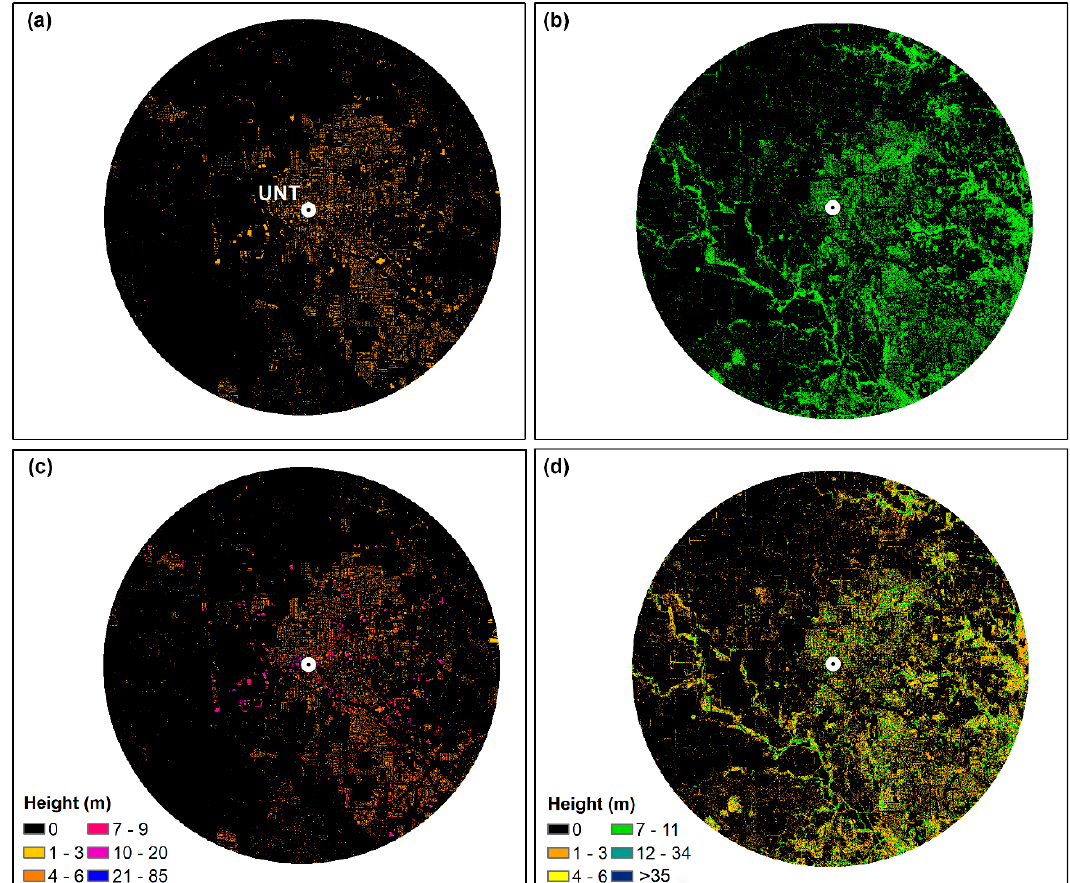
Figure 3. Maps of ( a ) building footprint, ( b ) vegetation footprint, ( c ) building height, and ( d ) vegetation height in meters in a 6-mile radius from the study area.